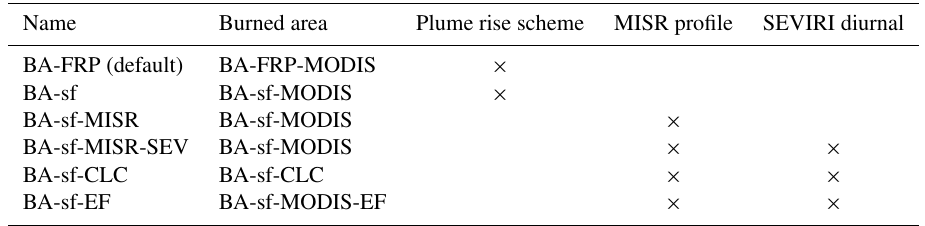
Table 4. CHIMERE sensitivity simulations. Burned area configurations are presented in Table 2.